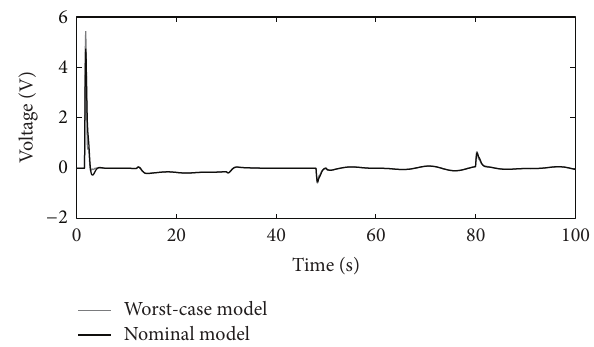
Figure 17: Output voltage of the RIC system with disturbance